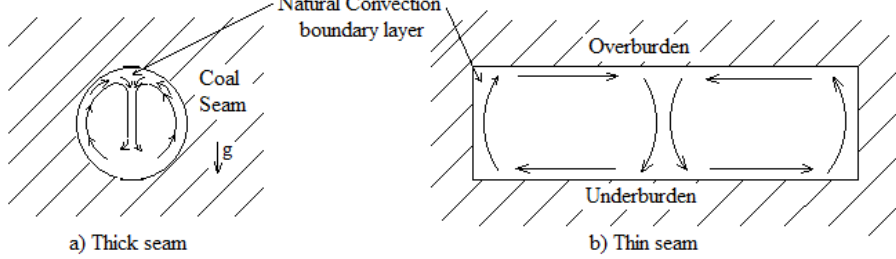
Figure 24. Assumed circulation patterns in the thick seam and thin seam configurations (redrawn from Schwartz et al. [62]).